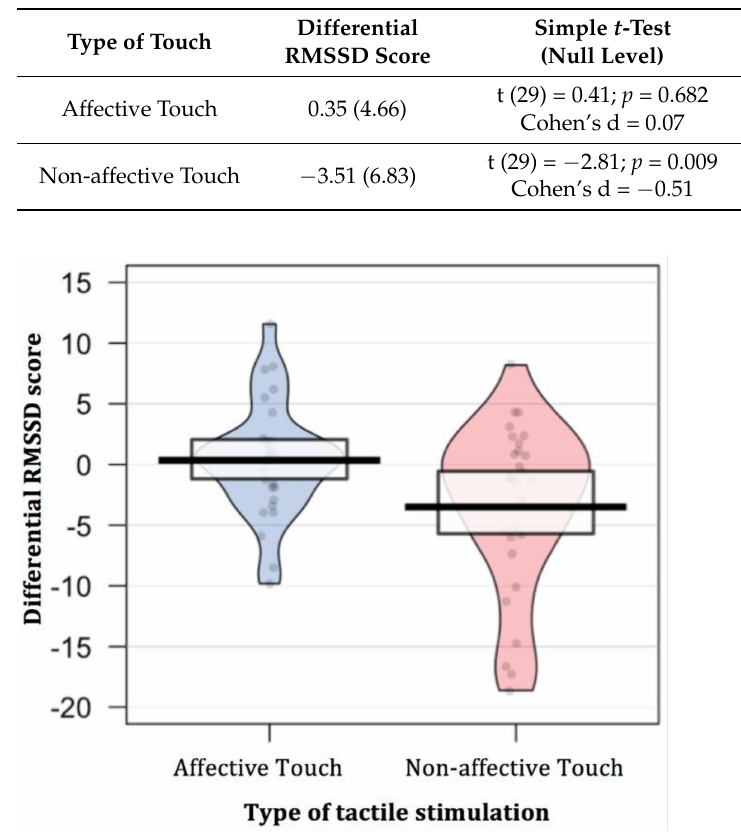
Figure 2. Differential RMSSD score during the two tactile stimulations compared to the pre-stimulus resting period. In the affective touch condition infants’ did not show a variation of RMSSD in response to touch, whereas in the non-affective touch condition they showed a decrease in